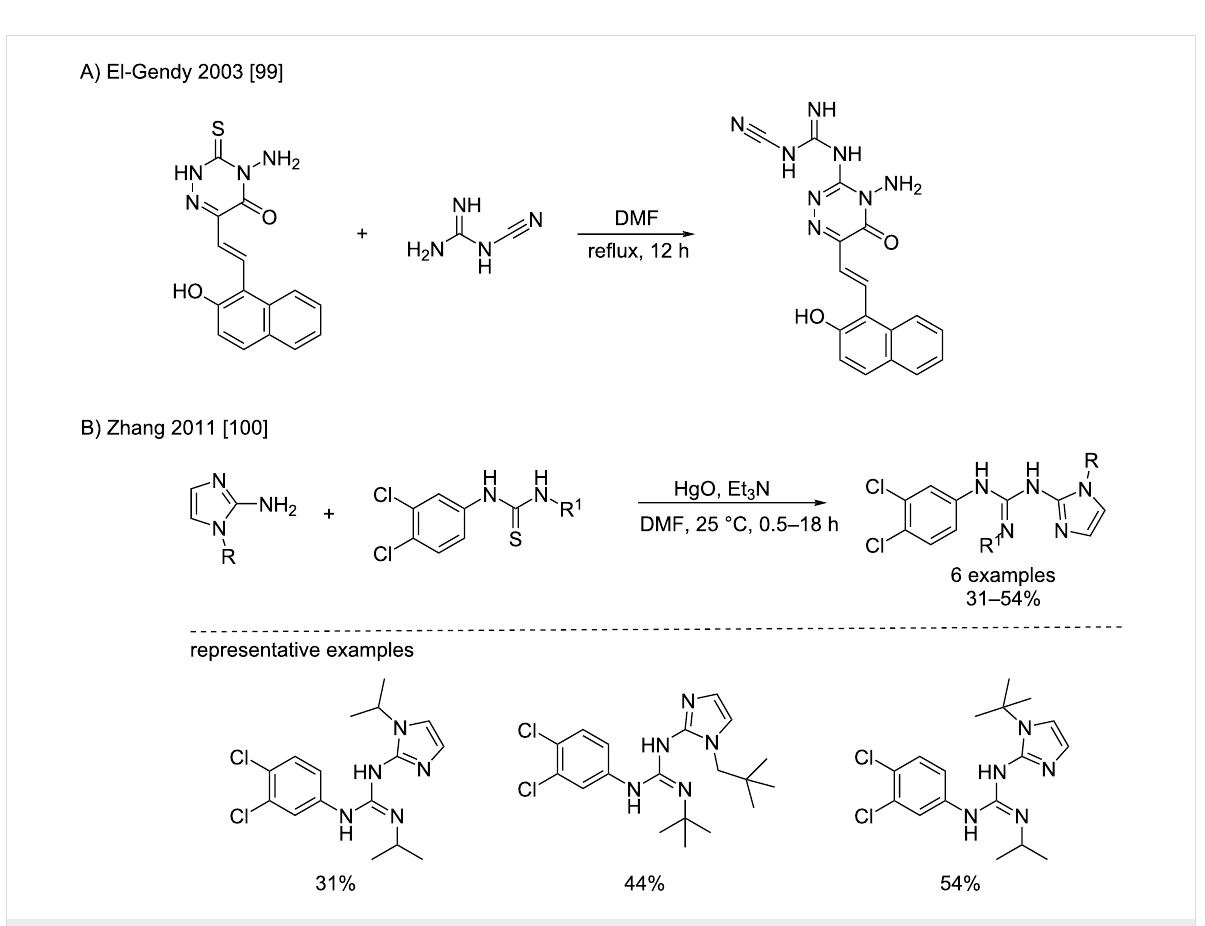
Scheme 55: Condensations of guanidine-like structures with thioureas